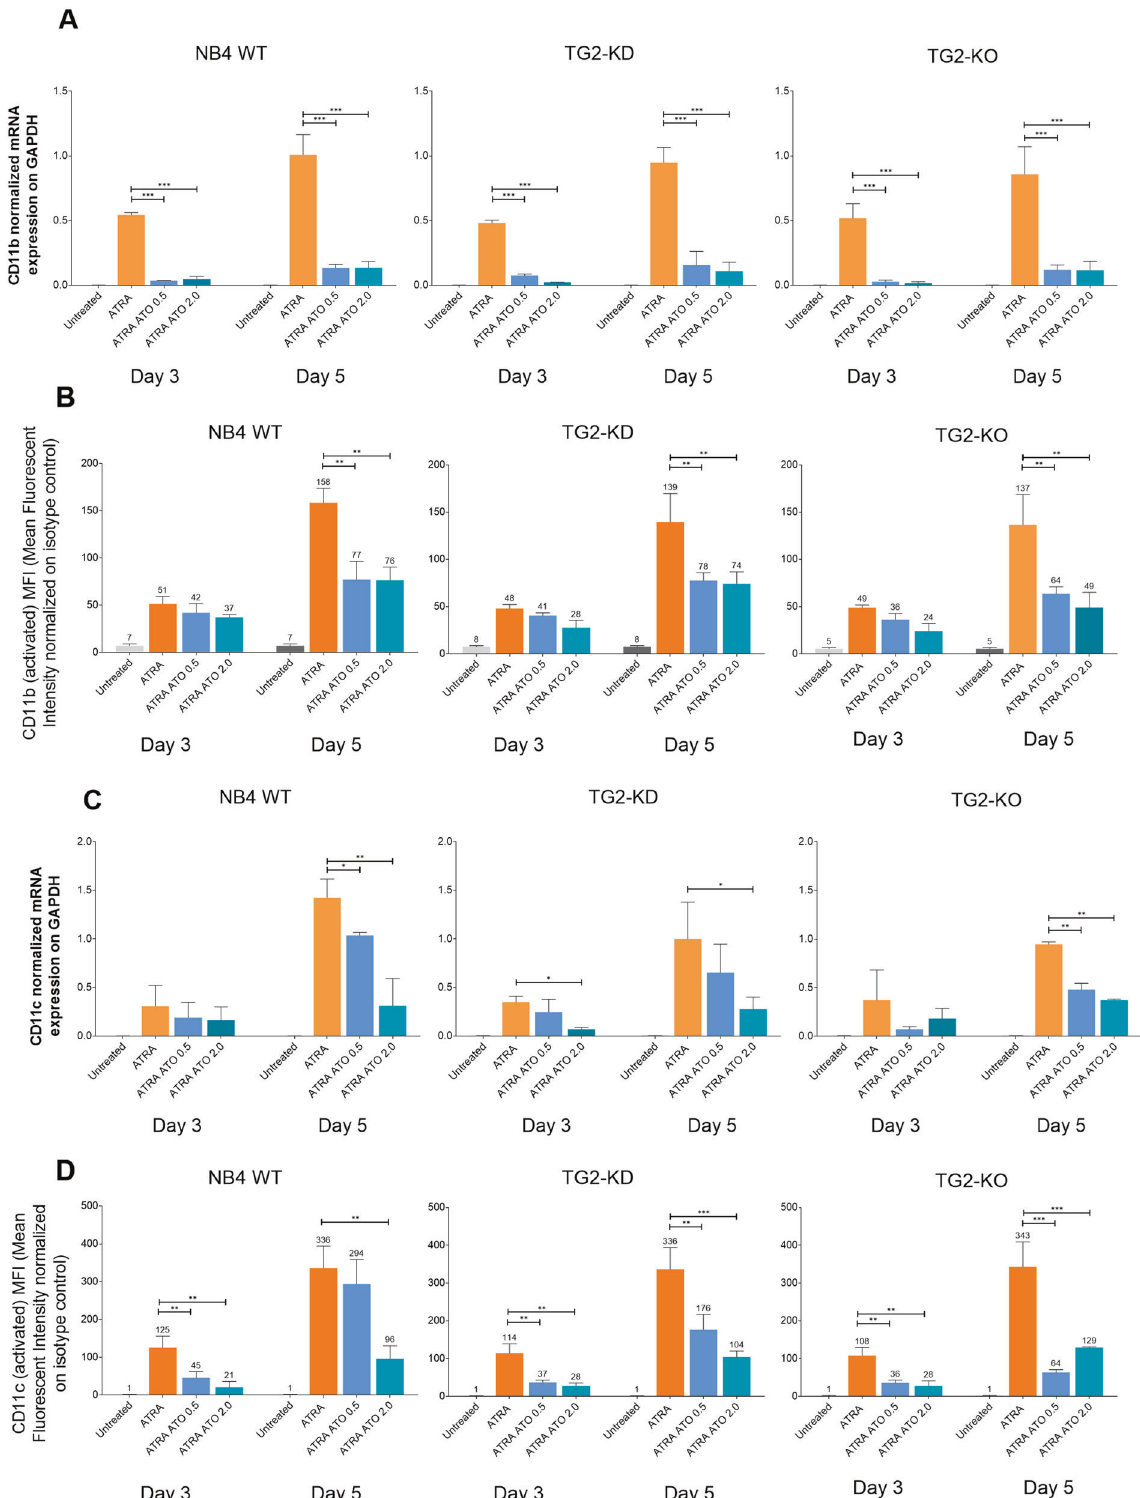
Fig. 2 ATO suppresses the expression of leucocyte β 2 integrin CD11b/CD18 and CD11c/CD18. A Relative mRNA expression of CD11b at the indicated days by RT-qPCR normalised to GAPDH ( n = 3). B Flow cytometry analysis of cell surface expression of the differentiation marker CD11b/CD18 ( n = 3). C Relative mRNA expression of CD11c measured by RT-qPCR normalised to GAPDH ( n = 3). D Flow cytometry analysis of cell surface expression of differentiation marker CD11c/CD18 ( n = 3). Measurements were conducted in triplicate; values were validated by Flowing software 2.5.1. Statistical analysis was conducted by two-way ANOVA (Bonferroni post hoc test; * p < 0.05, ** p < 0.01 and *** p < 0.001, **** p < 0.0001).